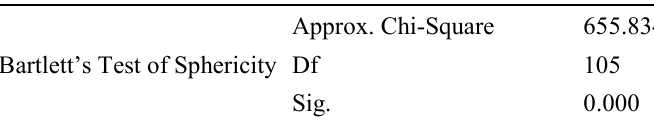
Table 6. KMO and Bartlett's Test for Ways of Improving Productivity